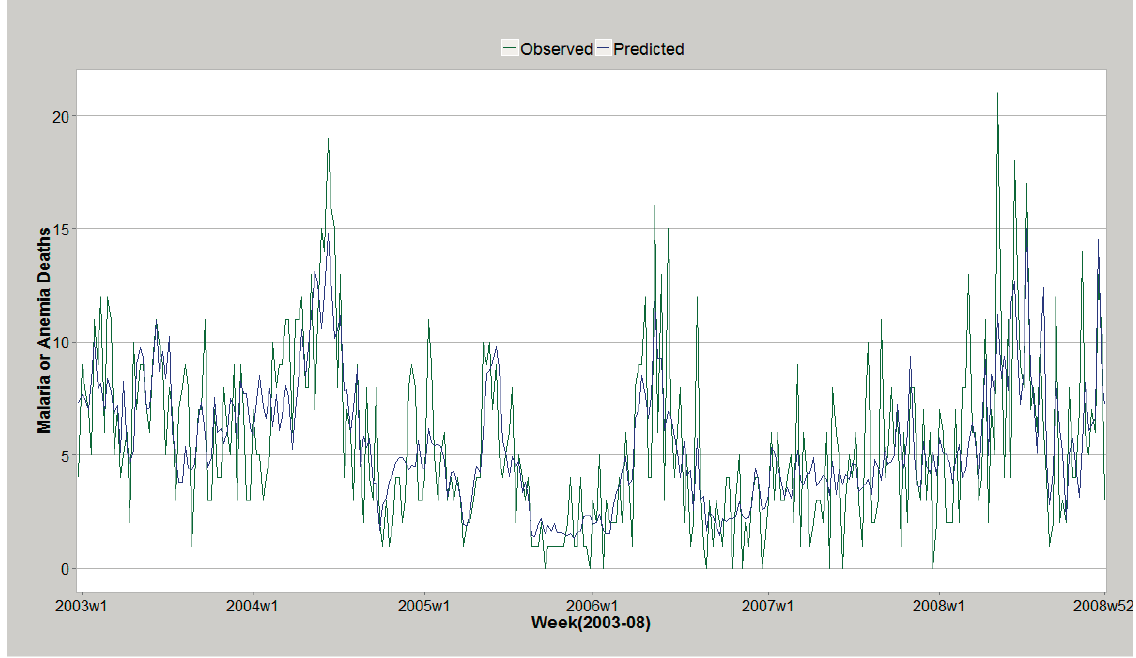
Figure 4. Relative risks of Malaria/Anemia mortality in children under five years with weekly cumulative precipitation at different lag strata.